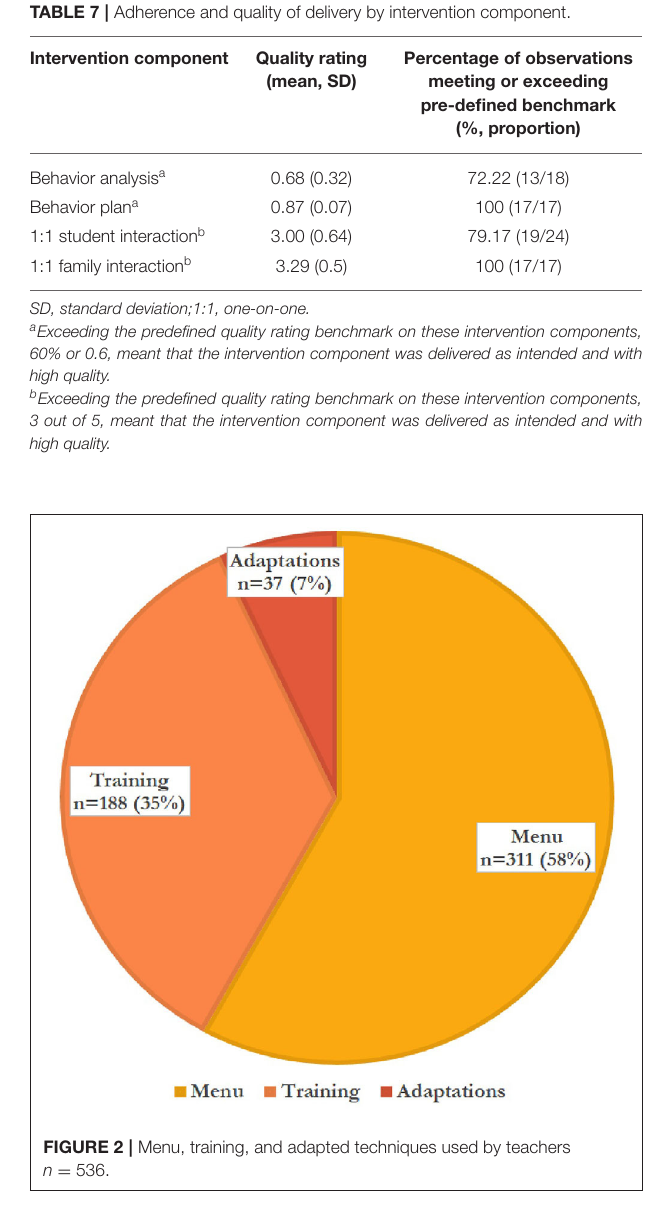
TABLE 6 | Student mental health profile per the ASEBA TRF. TABLE 7 | Adherence and quality of delivery by intervention component.